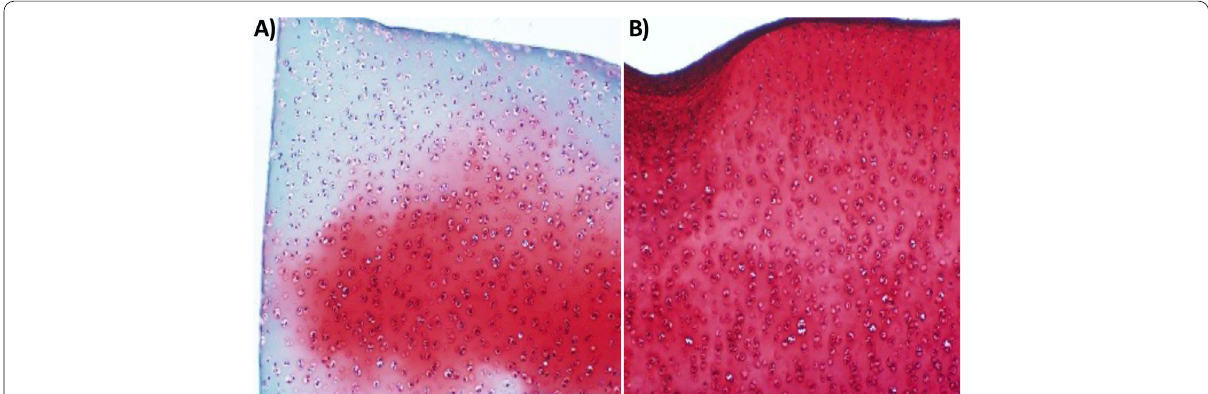
Fig. 4 Histological Analysis of Aggrecan in Bovine Articular Cartilage Explants. Histological analysis of aggrecan in bovine articular cartilage explants A treated with IL‑1B alone and B treated with CCEF stimulation and IL‑1B for one